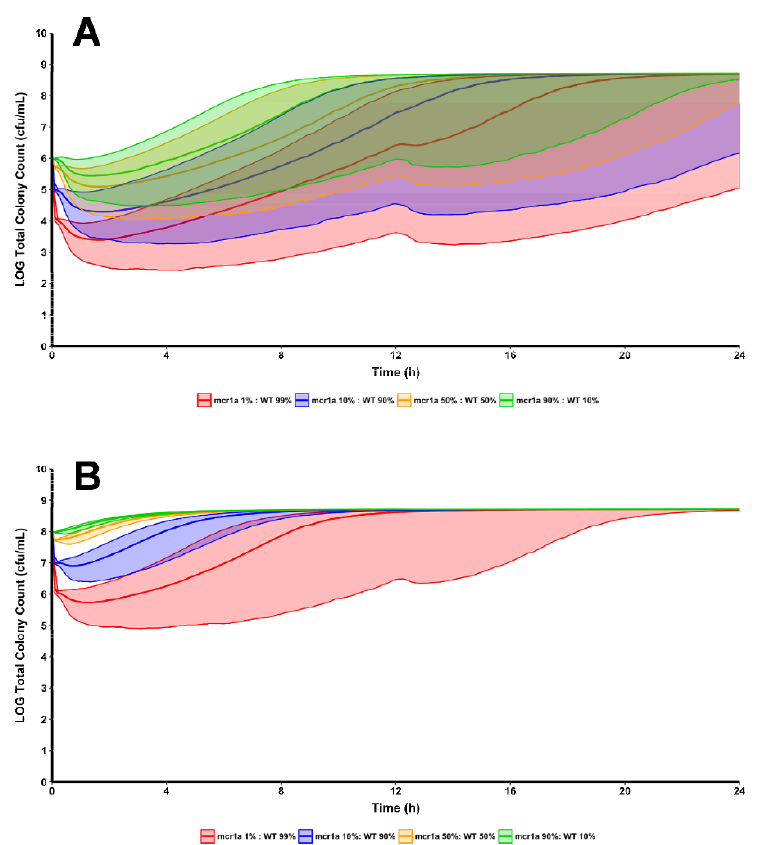
Figure 3. Using the same regimen structure implemented in the development of the mechanism-based model, simulations were conducted to see the effects of polymyxin B treatment against a bacterial population composed of varying proportions of WT and mcr1a cells. Simulations were conducted at both a 10 6 cfu/mL ( A ) and 10 8 cfu/mL ( B ) starting inoculum to explore the differences in regrowth pattern when there is an absolute increase in mcr-1 -harboring cells, even if the proportion of cells remains constant.